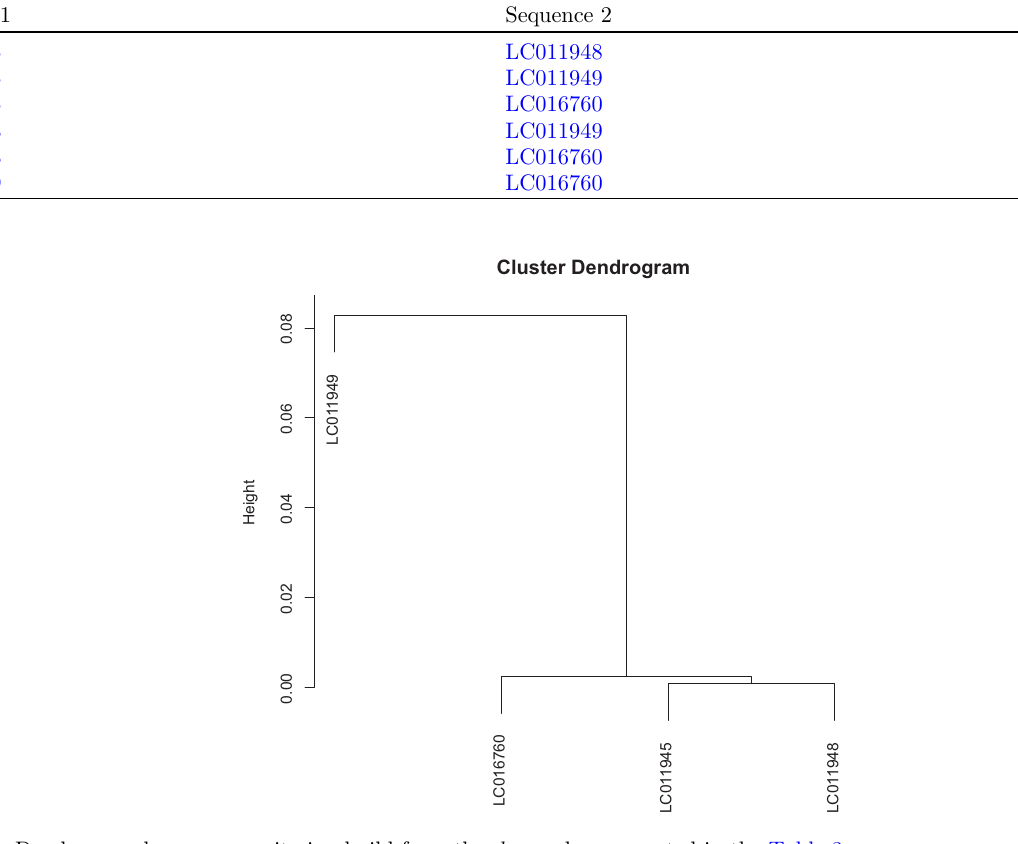
Figure 2. Dendrogram by average criterion build from the d max values, reported in the Table 3. Table 4. Value of V (De fi nition 2.2) for each sequence (see Table 2), ordered by increasing magnitude from top to bottom. In bold letter the most representative sequence (top) and the least representative sequence